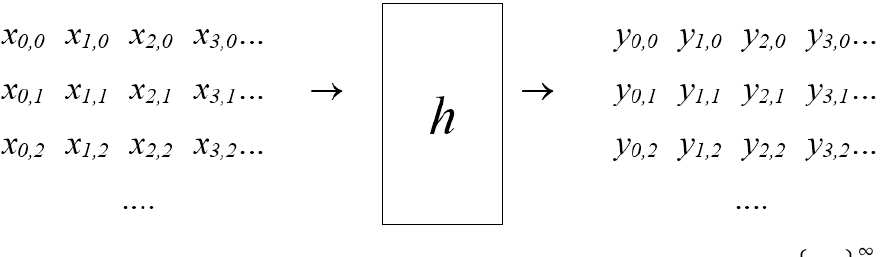
(cid:110) (cid:111) ∞ x . . Figure 6. Identification of the linear operator h by means of a set of input signals x  n , i i = 0 n i i =